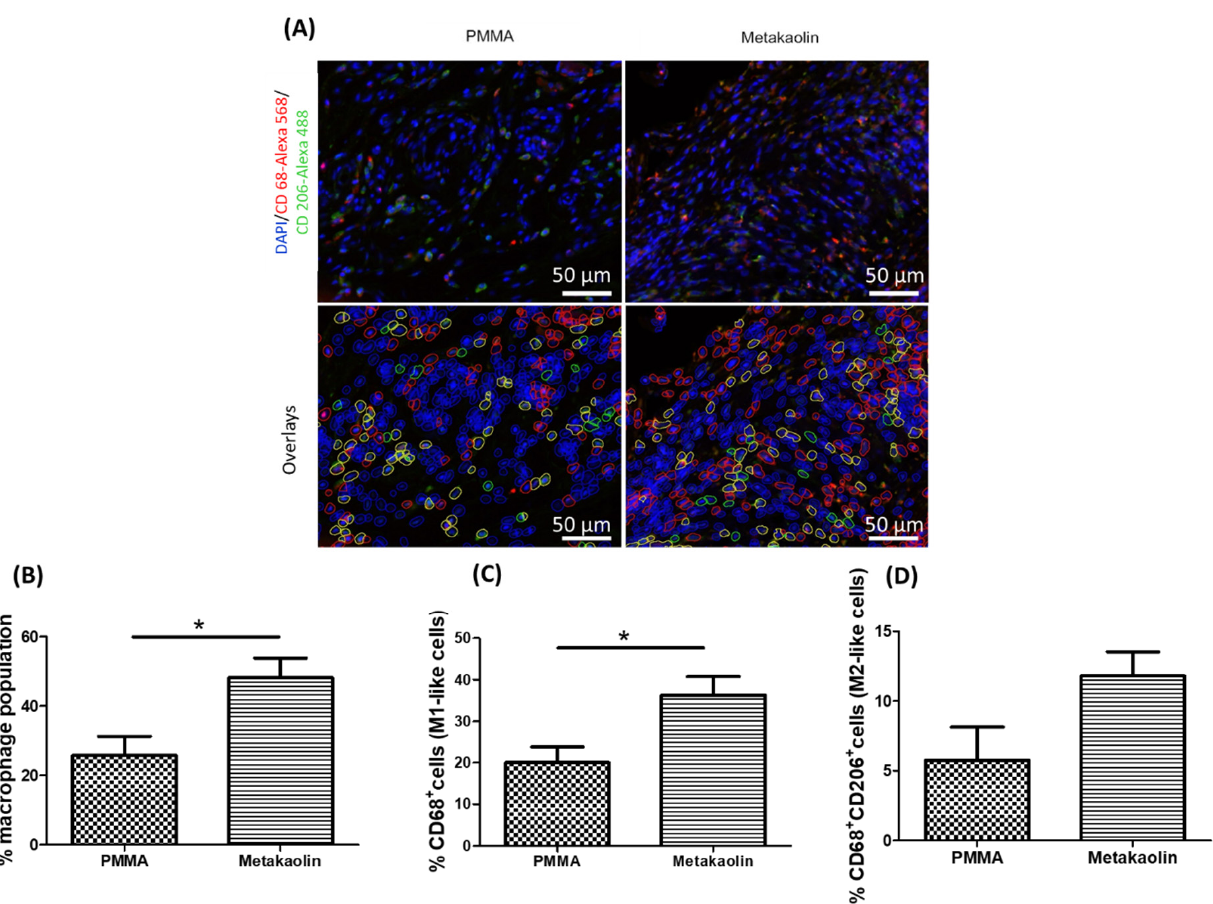
Figure 5. Identification and quantification of M1-like and M2-like macrophages in PMMA-IMs and metakaolin-IMs: ( A , top panel ) Representative immunolabeling with anti-CD68 (red) and anti-CD206 (green) antibodies and DAPI (blue) nuclear staining. ( A , bottom panel ) Illustration of semi-automatic macrophage quantification. Green objects represent satellite cells, and red and yellow objects correspond to M1-like and M2-like macrophages, respectively. Histograms show ( B ) the % total (M1-like + M2-like) macrophages in IMs, ( C ) the % M1-like macrophages and ( D ) M2-like macrophages. * p < 0.05.